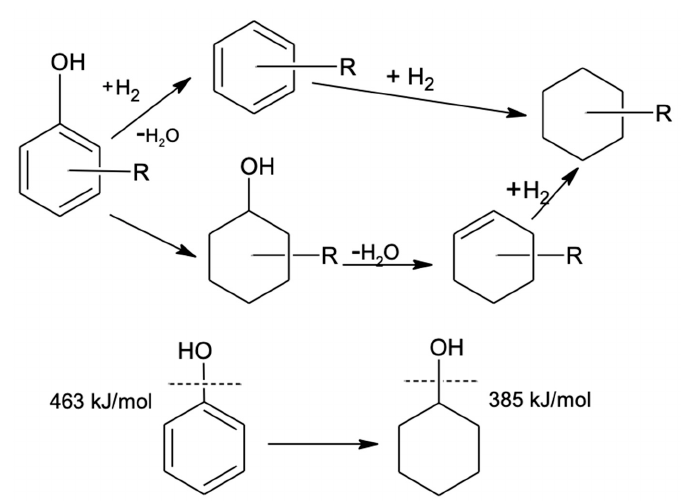
Figure 8. The reaction pathway of phenols. Reproduced from reference [82].